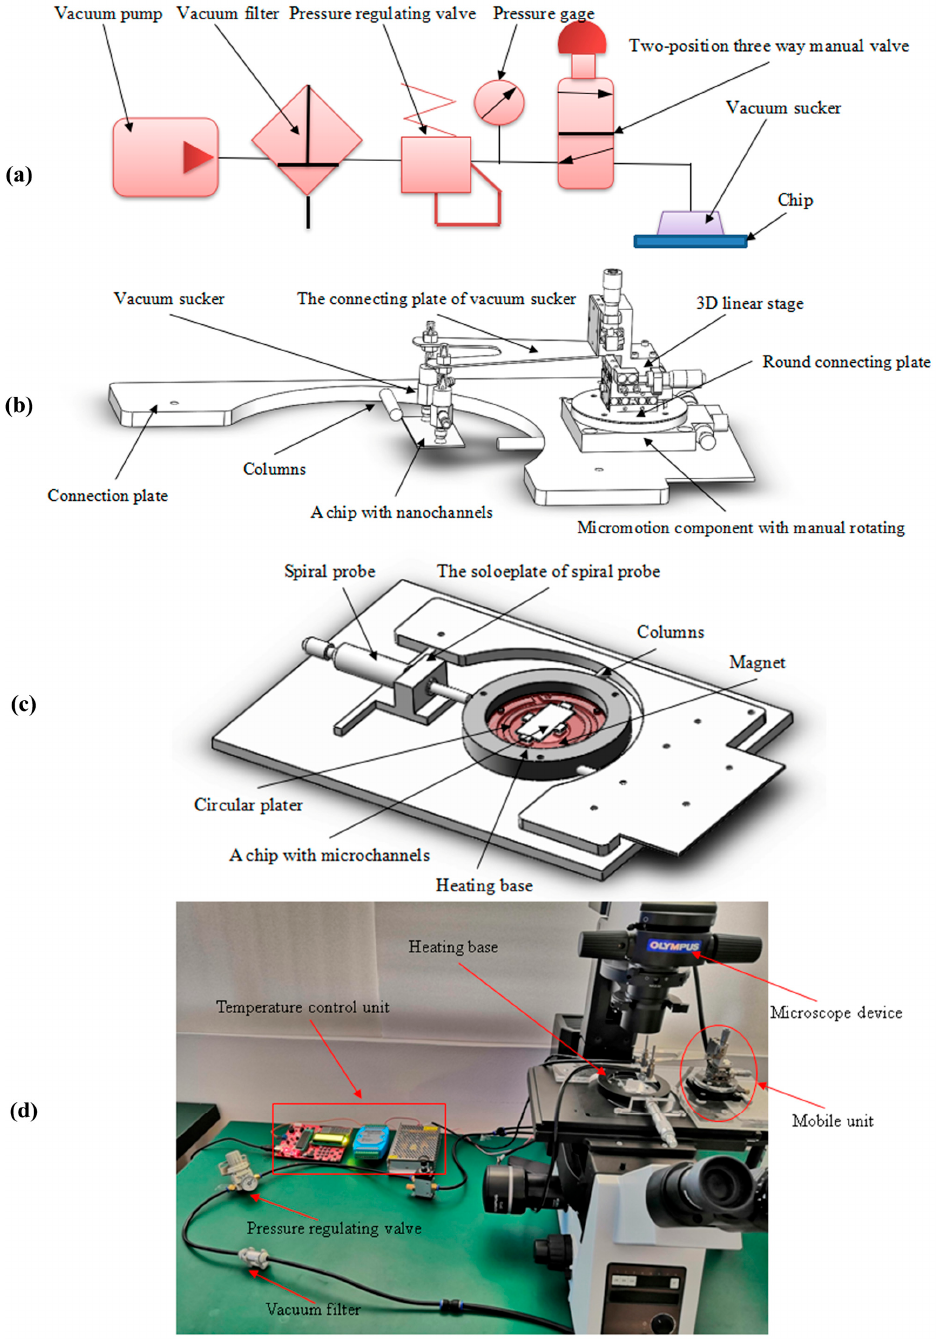
Figure 1. The alignment system for a micro/nanofluidic chip. ( a ) The vacuum device including a vacuum pump, a pressure regulating valve, and other components is adopted to realize the function of air path control and adsorb the chip with nanochannels through the vacuum sucker. ( b ) The mobile unit integrated with a 3D linear stage, a micromotion component with manual rotating, and other parts are employed to develop the movement of the chip with the nanochannels. The position adjustment of the chip with the nanochannels in the three-dimensional direction and horizontal direction is completed by adjusting the screw micrometer head. ( c ) The fixed unit composed of a screw micrometer, a spiral probe, and other parts is utilized to achieve the fixation of the chip with the microchannels. The heating base and the circular plater are introduced to implement the pre-bonding of the chip based on an ohmic heating principle. ( d ) The real images of the set up. The pre-bonding temperature is 60 °C for 2 h through regulating temperature control unit.